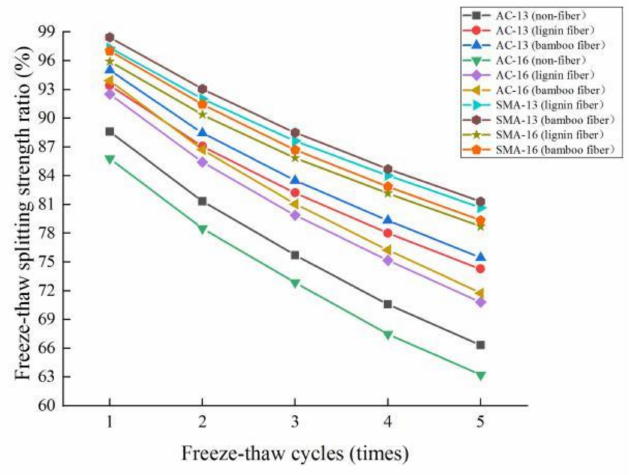
Figure 10. TSR test results of fiber asphalt mixture under different freeze-thaw